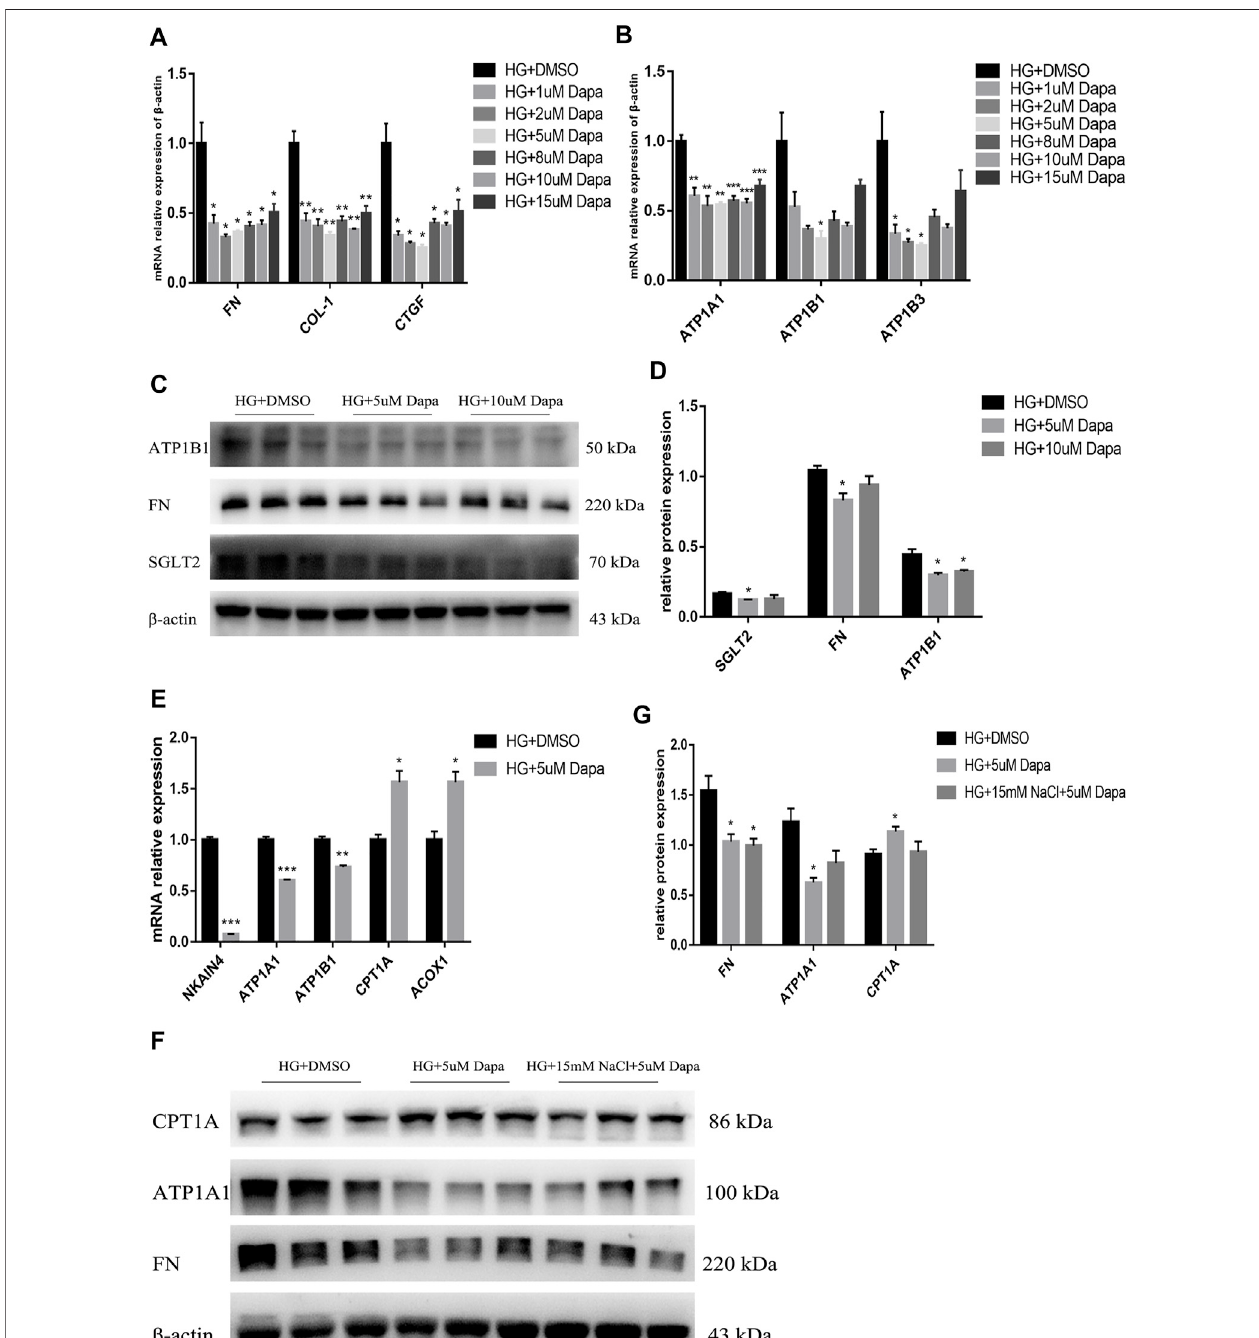
FIGURE8| Highsaltattenuatesgeneandprotein expressioninHG-cultured HK-2treatedwithdapagli fl ozin.Expressionof fi brosis-relatedgenes (A) andNa+/K + -ATPase-related genes (B) in HG-treated HK-2after exposure todifferent concentrations ofdapagli fl ozin. n (cid:1) 4per group. (C,D) Expressionof SGLT2, FN and ATP1A1 proteinsinHG-treatedHK-2afterexposureto5uMand10uMdapagli fl ozin. n (cid:1) 3pergroup. (E) Expressionoffattyacidmetabolism-relatedgenes. n (cid:1) 3pergroup. (F,G) Expression of FN, ATP1A1 and CPT1A proteins in HK-2 co-cultured with HG, 15 mM NaCl and 5 uM dapagli fl ozin. n (cid:1) 3per group. All data are mean ± SEM, * p < 0.05, ** p < 0.01 and *** p < 0.001 vs. HG + DMSO group.